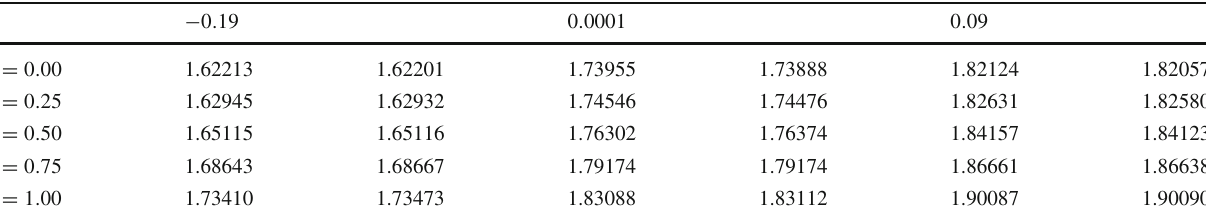
Table 1 The critical value of chemical potential (cid:12) c = q μ c / r s of the holographic p-wave superfluid model obtained by the analytical S–L method (left column) and numerical calculation (right column) with a